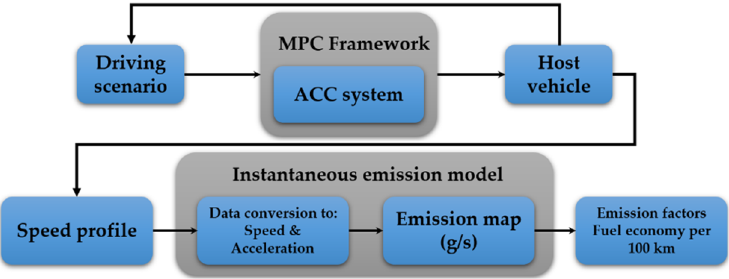
Figure 4. Schematic of overall data transfer .